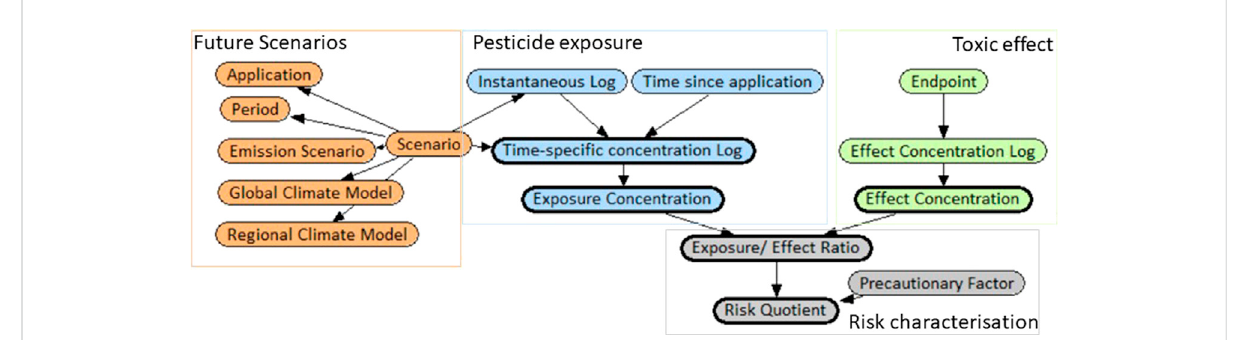
FIGURE 1 Conceptual model for the risk estimation of a pesticide. Pesticide exposure derives input from the WISPE platform and is determined by the associated future scenarios. The toxic effect nodes together with the exposure concentration derives the risk quotient under risk